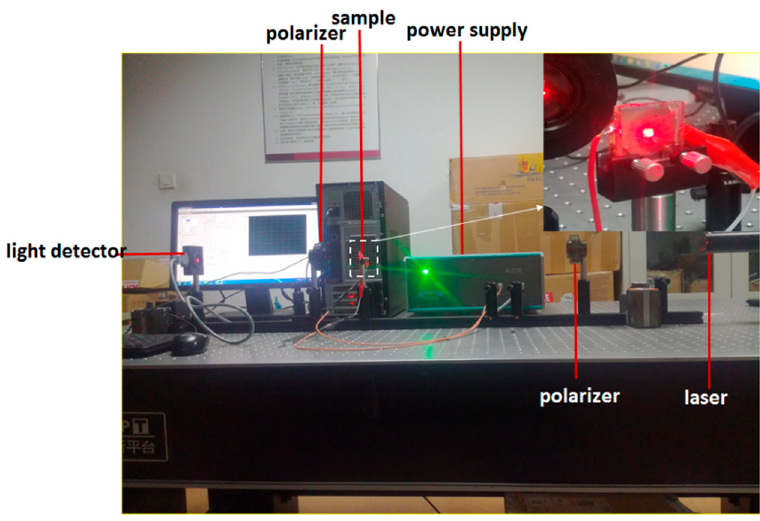
Figure 7. Experimental platform for measuring the response time of the MAs.